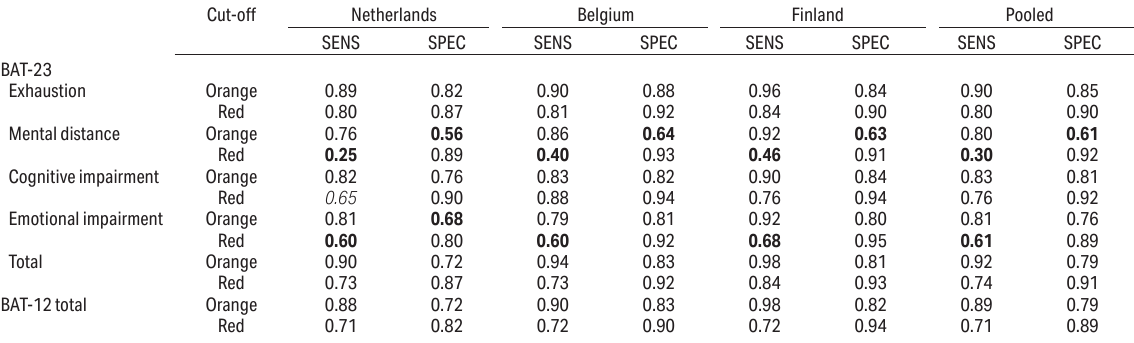
Table 5. Sensitivity (SENS) and specificity (SPEC) using pooled values for the Burnout Assessment Tool (BAT). Note : A table of all operating character- istics (sensitivity, specificity, 1-specificity and Youden-index for each BAT score) is available upon request from the first author. Bold denotes <0.70.